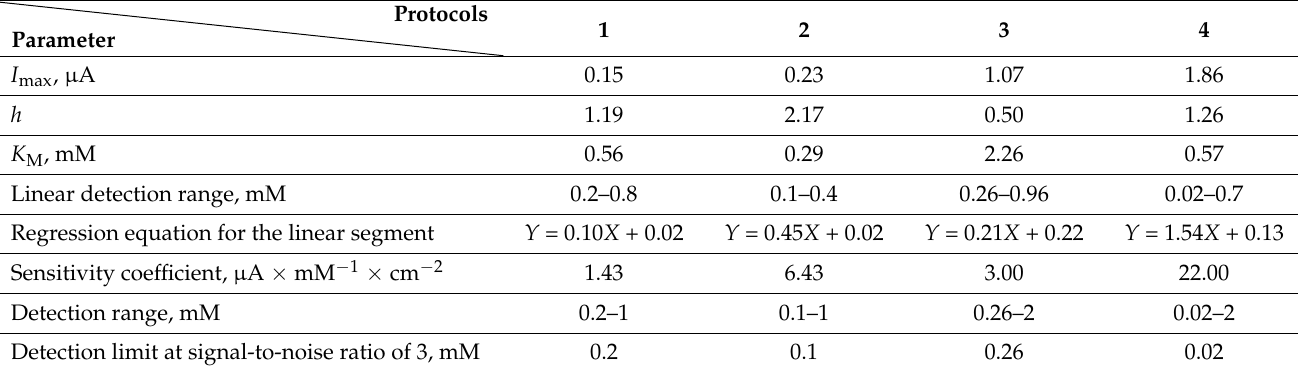
Table 2. Comparison of the main parameters of biosensors with different compositions of composite material on the electrode